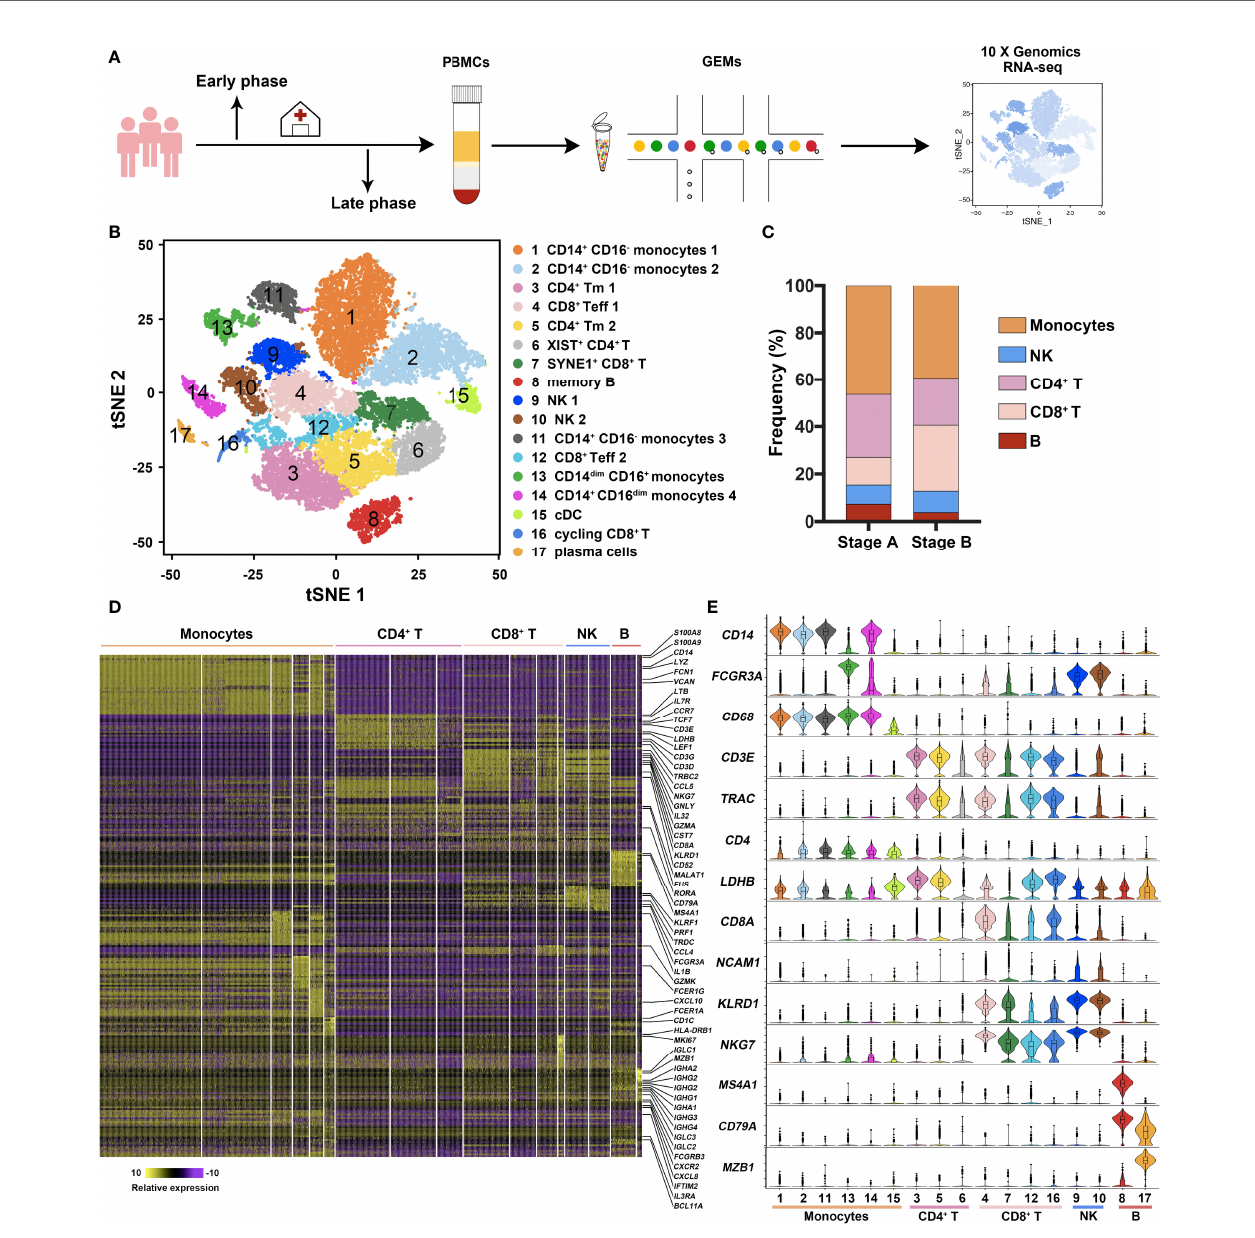
FIGURE 1 | Study design and immune pro fi le of COVID-19 patients. (A) Schematic depicting the overall design of the study. Three moderate COVID-19 patients (C1, C2, and C3) were recruited, and peripheral blood was collected twice during hospital admission. The fi rst peripheral blood samples collected immediately after admission indicated as the early phase sample. After the nucleic acid detection of SARS-CoV-2 converted negative, the second sample (late phase) was collected. Peripheral blood mononuclear cells (PBMCs) were isolated and prepared into nanoliter-scale Gel Bead-In-Emulsions (GEMs) with 10× genomics Chromium Single Cell 3 ′ Reagent Kits. After reverse transcription, cDNA ampli fi cation, and library construction, gene expression libraries were sequenced and analyzed. (B) tSNE representation of immune cell clusters identi fi ed in sc-RNA seq data. Data of all six samples (two samples each patient) were pooled and analyzed. (C) Frequency distributions of fi ve cell types of the three patients in in both stages A and B. Monocytes, CD4 + T cells, CD8 + T cells, NK cell, and B cells were represented as orange, medium lavender magenta, misty rose, blue, and brick red, respectively. (D) Heatmap of gene expression in fi ve major immune cell subsets. Representative genes with high expression were listed beside. The relative expression level was de fi ned from 10 to − 10 and colored from yellow to purple. The higher the gene was expressed, the yellower the color was represented. (E) Expressions of representative genes in each subset were exhibited as violin